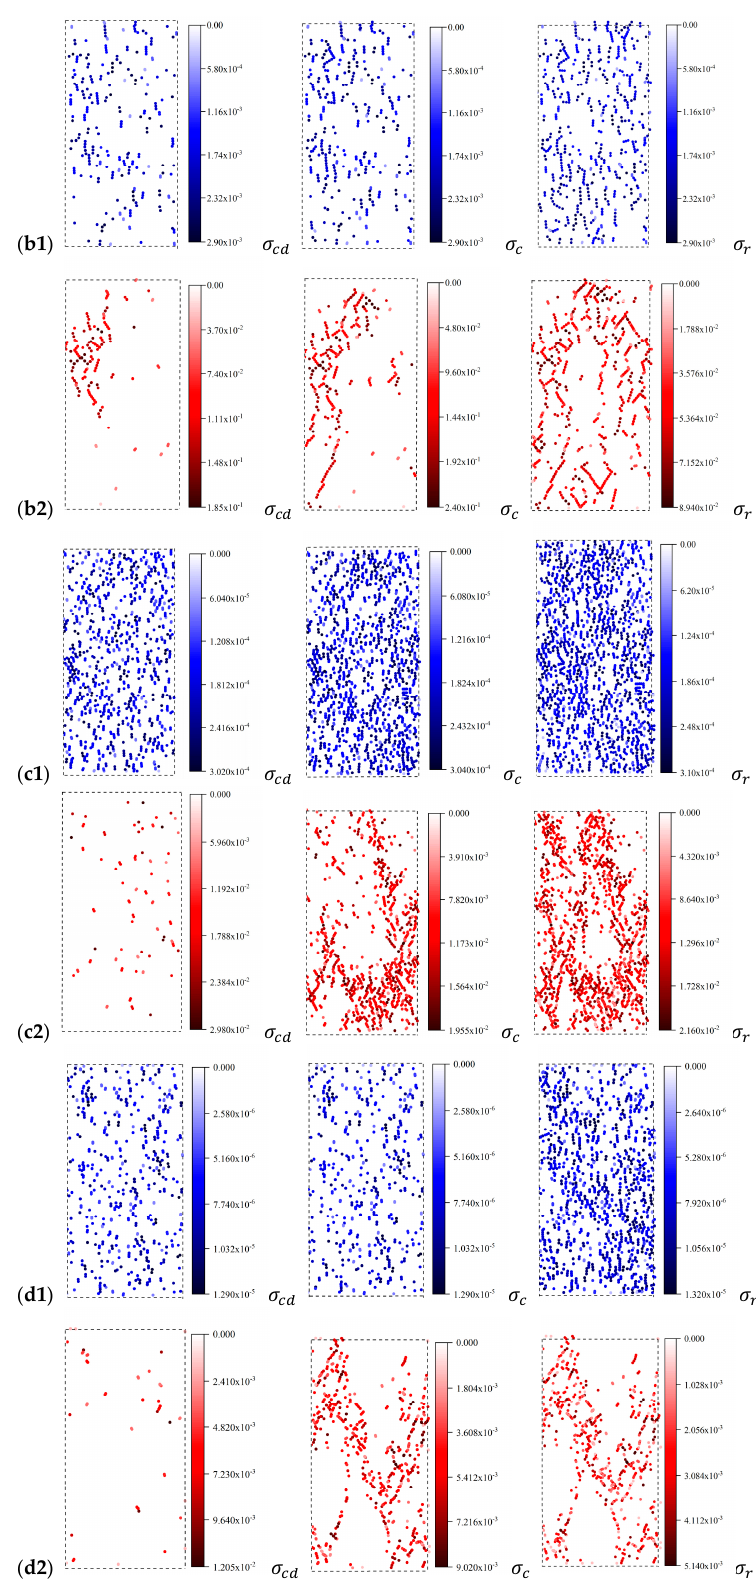
Figure 12. Spatial distribution of the dissipated energy in four rock samples: ( a ) LdB granite, ( b ) Augig granite, ( c ) TS, and ( d ) coal. Note: (1) a1 , b1 , c1 and d1 are the dissipated energy of tensile cracks, and a2 , b2 , c2 , and d2 are the dissipated energy of shear cracks; (2) the color of the spheres represents the energy dissipated by